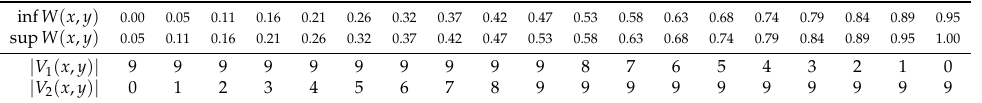
Figure 7. Guided supersampling step (see Section 2.5): ( a ) SMR stacked median I 12 , ( b ) final restored image and ( c ) details of it, ( d ) weight mask W for the guided supersampling, ( e ) SMR+ weighted stacked median H 12 , ( f ) final restored image, ( g ) a detail of it, and ( h ) its differences with respect to the SMR output. Best viewed in color. The reader is invited to zoom in on the electronic version of the manuscript in order to better appreciate the visual differences. Table 1. The cardinality of the sets V 1 ( x , y ) and V 2 ( x , y ) according to the weight W ( x , y ) range (see Section